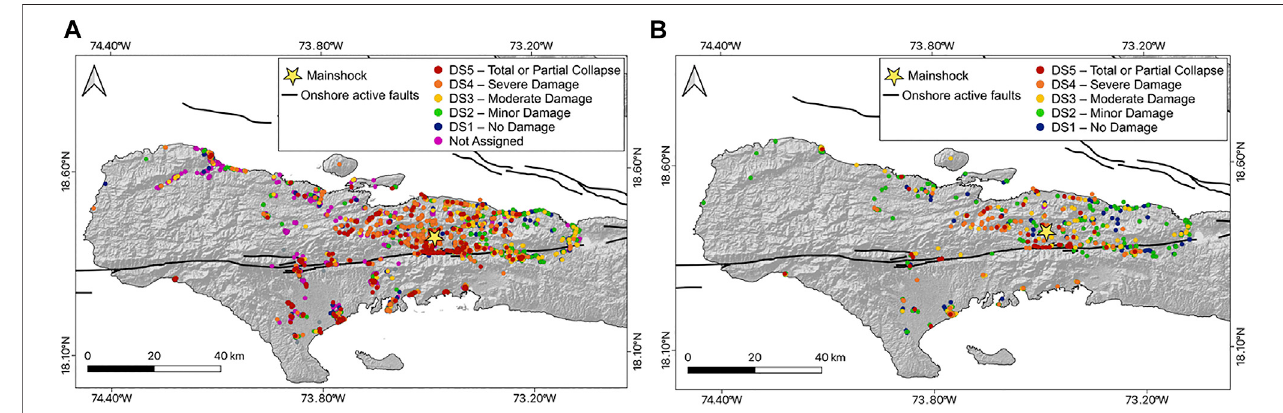
FIGURE 10 | Overview of the StEER Fulcrum database showing the spatial distribution and assigned damage status of (A) all recorded structures, and (B) all surveyed schools.